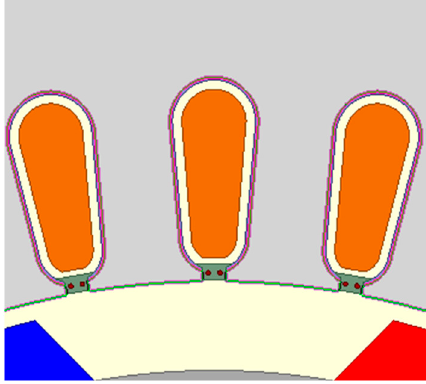
( b ) Figure 11. Characteristics of capacitance changes: ( a ) C wr , ( b ) C ws and C sr depending on the slot open- ing width B s0 . The simulation tests show that the reduction of the slot opening width B s0 causes the reduction of the C wr capacitance. Other capacitances remain practically unchanged. It is worth emphasizing here that, in general, case changes in the shape of the slot of a ferro- magnetic core are related to changes in the parameters of the electromagnetic circuit of the machine. Moreover, from a technological point of view, the reduction of the slot open- ing makes the stator winding process more difficult. In addition, the use of a fully open stator slot [31] may increase the C wr capacitance, exposing the machine bearings to unsafe levels of voltage u b . For the reference model, the slot opening B s0 is 2 mm, and the capaci- tance between the stator winding and the rotor is 19 pF. This value is treated later in the article as a reference value. 3.2. Shielding Wire Placed in the Slot Wedges—Variant B The second analyzed variant was divided into two cases. In the first case, to limit the internal capacitance of the machine between the stator winding and the rotor, a screen in